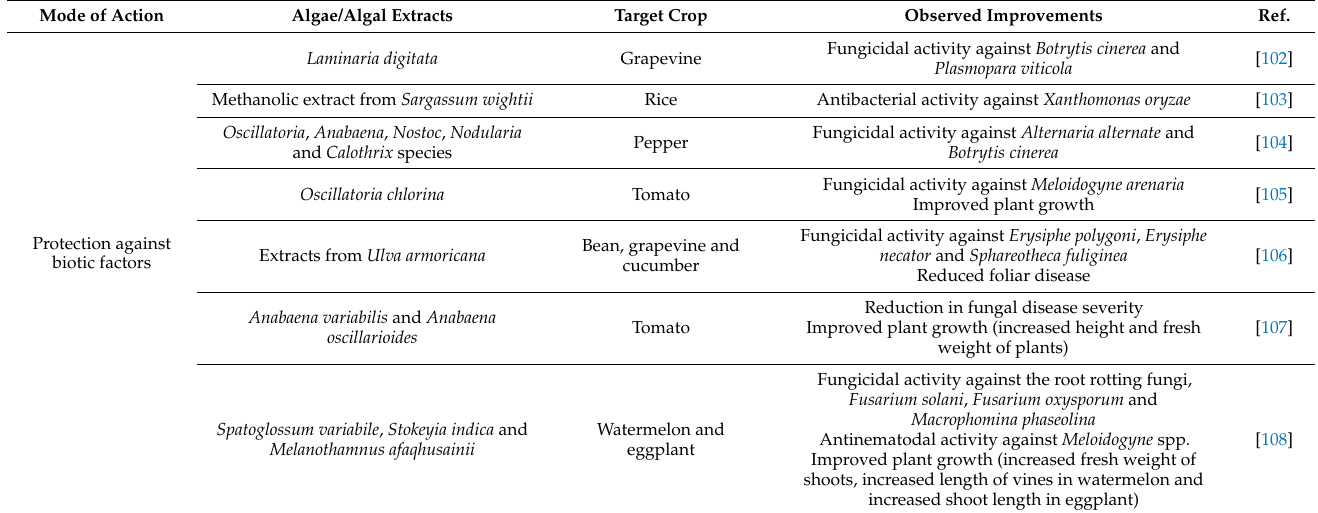
Table 3. Impacts of microalgae and cyanobacteria (and their metabolites) on crops’ protection. Mode of